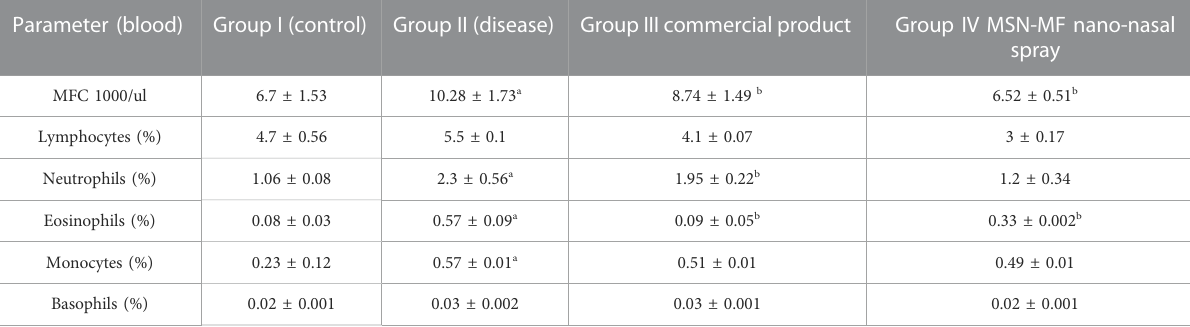
TABLE 5 Mean ± SD of MFC and DLC in blood in all groups (n =